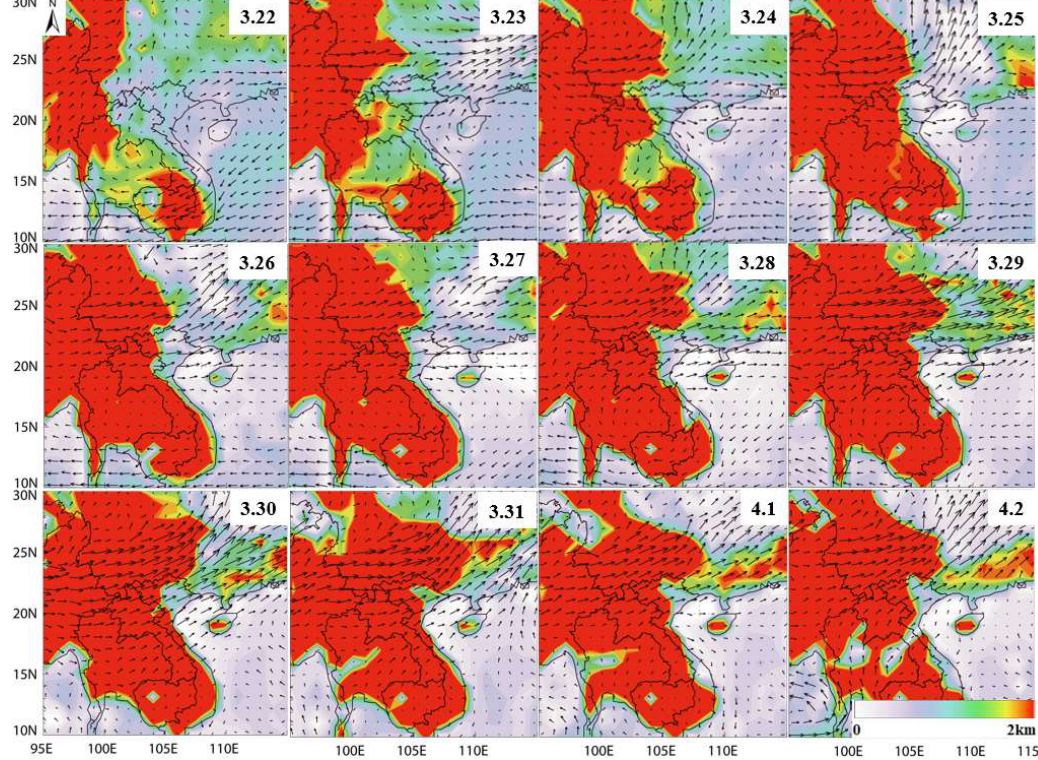
Figure 7. Wind field and boundary layer height at 750 hPa.